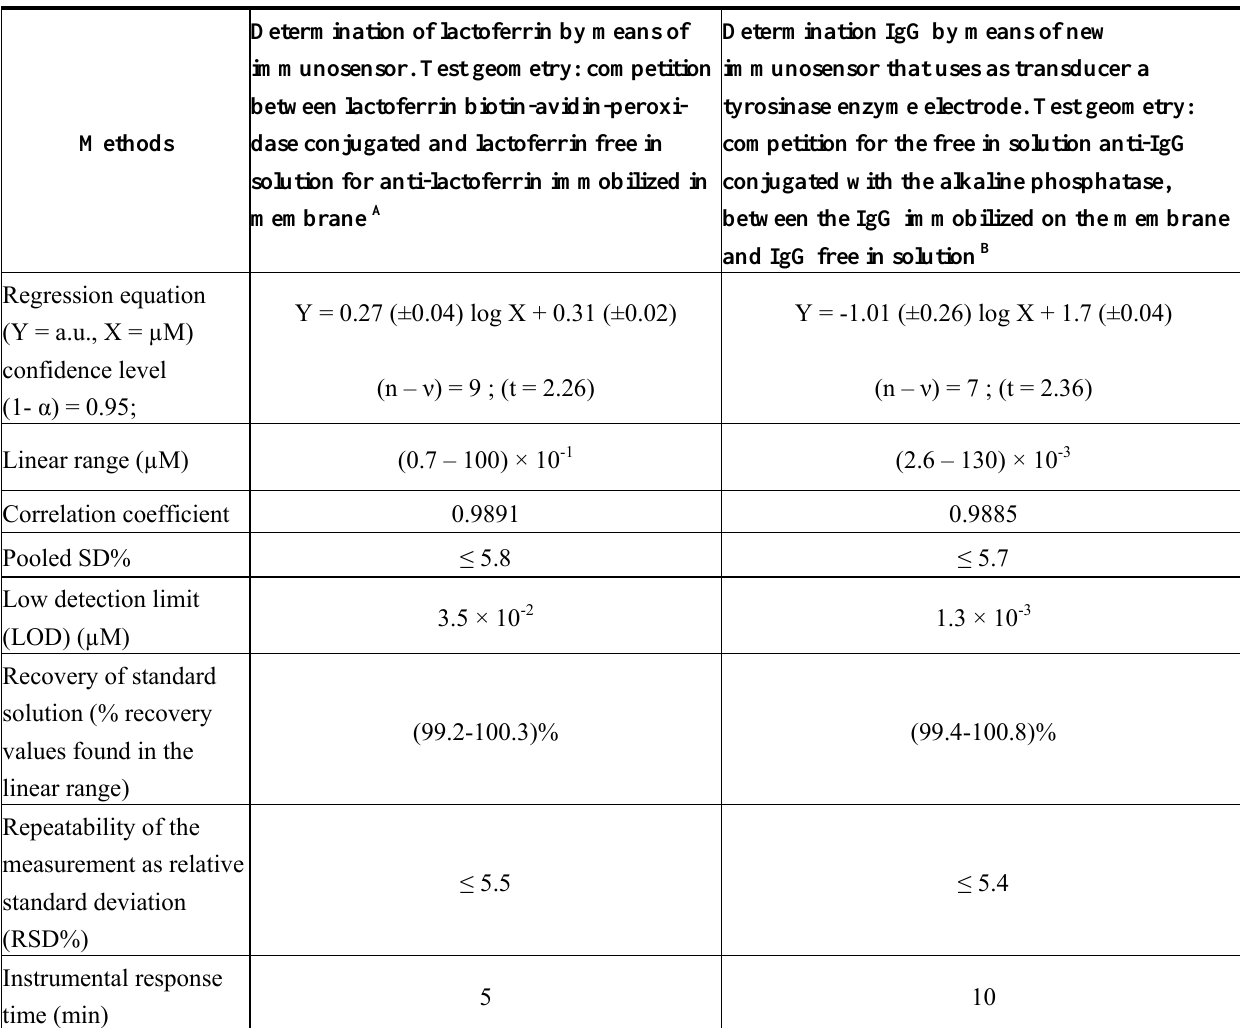
Table 1. Analytical characterization of two immunosensor methods for lactoferrin determination and for IgG determination using competitive